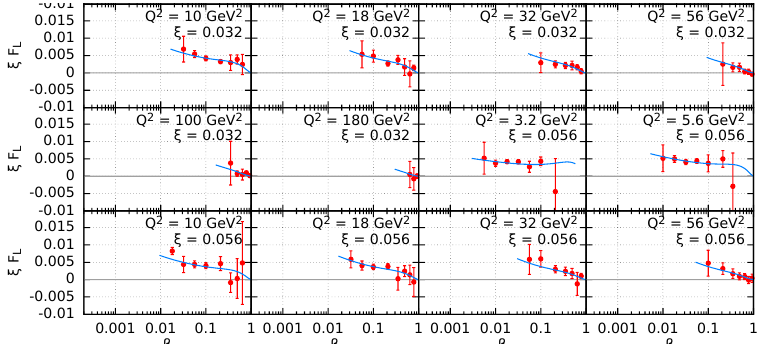
( 3 ) Figure 5: F D from fits to pseudo-data simulated at 17 center-of-mass energies for L δ = 2% and integrated luminosity of 10 fb − 1 — a small subsample. sys